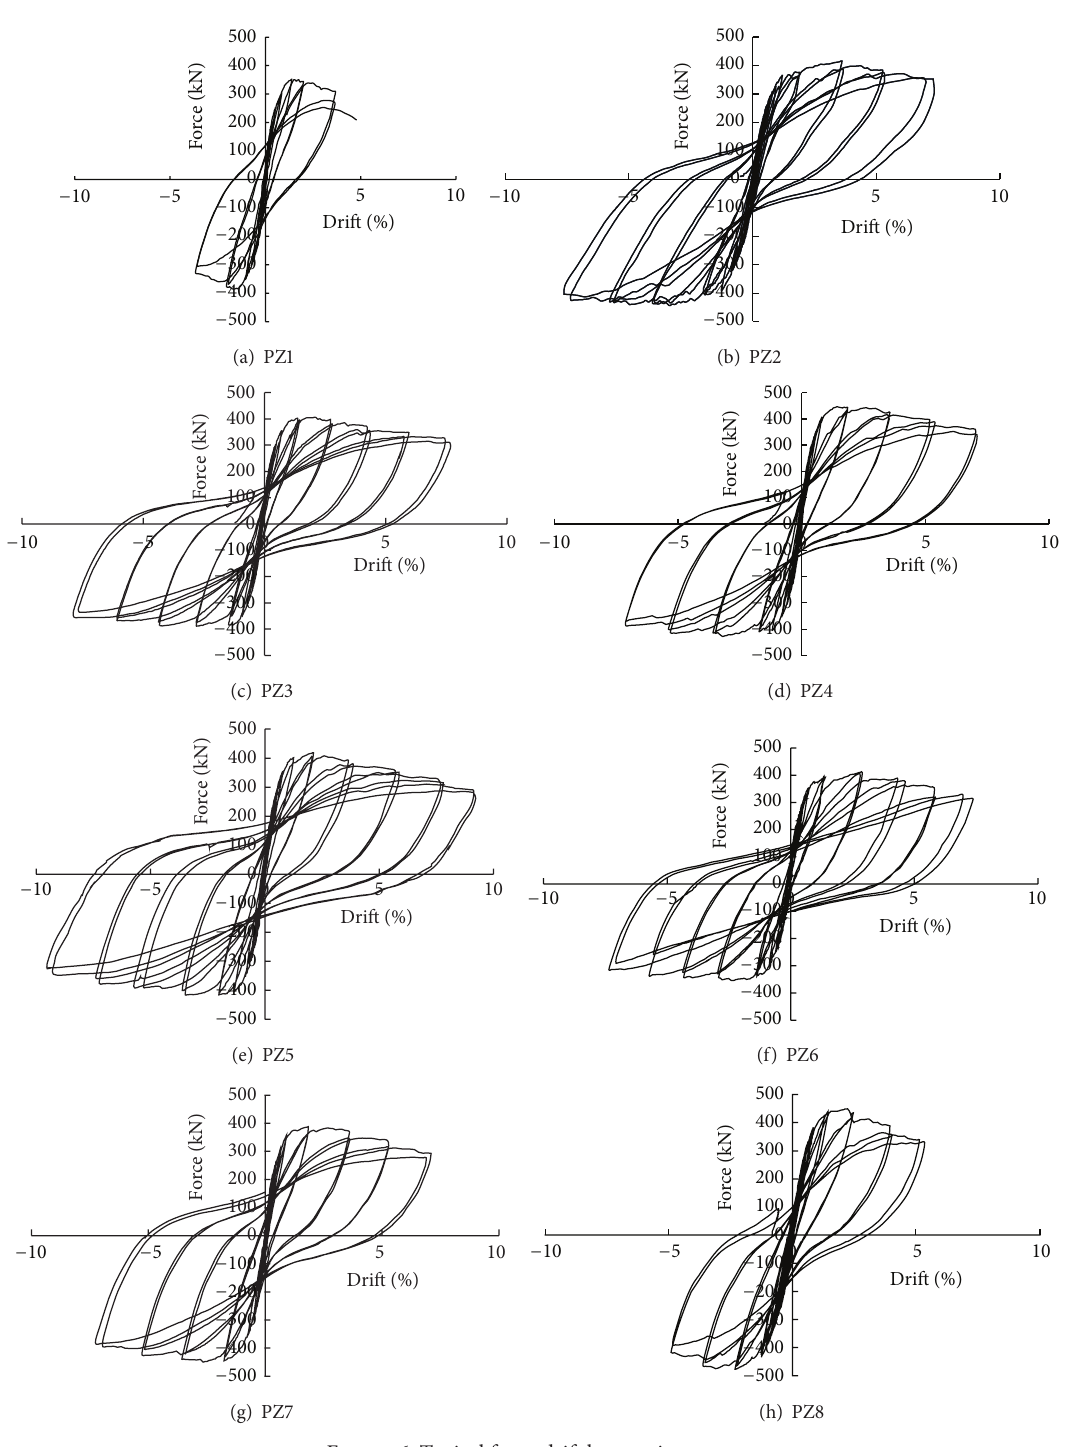
Figure 6: Typical force-drift hysteretic